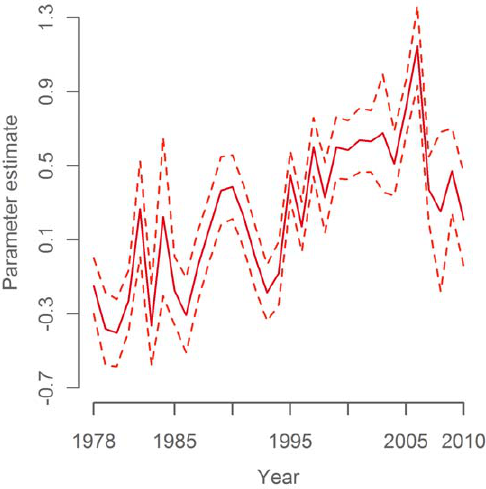
Figure 5. Year parameter in the temperature model. Parameter estimate (solid line) with 95% confidence interval (dashed lines) relative to mean predicted value.